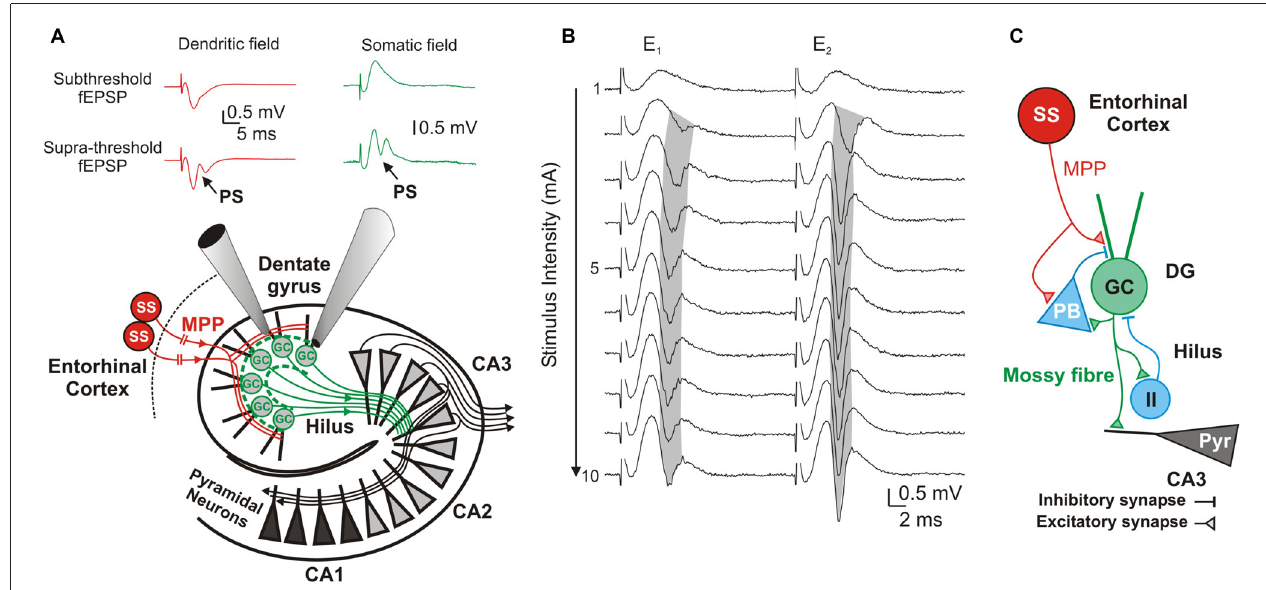
FIGURE 1 | Components and information flow in the dentate gyrus (DG) network. (A) Schematic of the network showing information-transfer from spiny stellate (ss) neurons through the medial perforant path (MPP) to the DG and Cornu ammonis 1–3 (CA1–3) fields. Inserts show typical dendritic (red) and somatic (green) recordings at, respectively, the DG’s inner molecular layer and stratum granulossum. Top: Subthreshold fEPSPs; Bottom: Suprathreshold fEPSP eliciting a field granule cell (GC)’s action potential (population spike; PS). (B) DG response to paired-pulse stimulation to the MPP with a 20 ms inter-stimulus interval. Progressively stronger stimuli (range 1–10 mA) produce increasingly larger fEPSPs until saturation of the response. Supra-threshold fEPSPs (E 1 and E 2 ) elicit PS 1 and PS 2 . Note the gradual shortening of PS 1 ’s latency (gray shadow) while increasing stimulus intensities, and its prolongation during the strong stimulation (7–10 mA) by probable recruitment of feed-forward inhibition. (C) Diagram of the DG circuit including feed-forward inhibition by potential pyramidal basket-cells (PB),